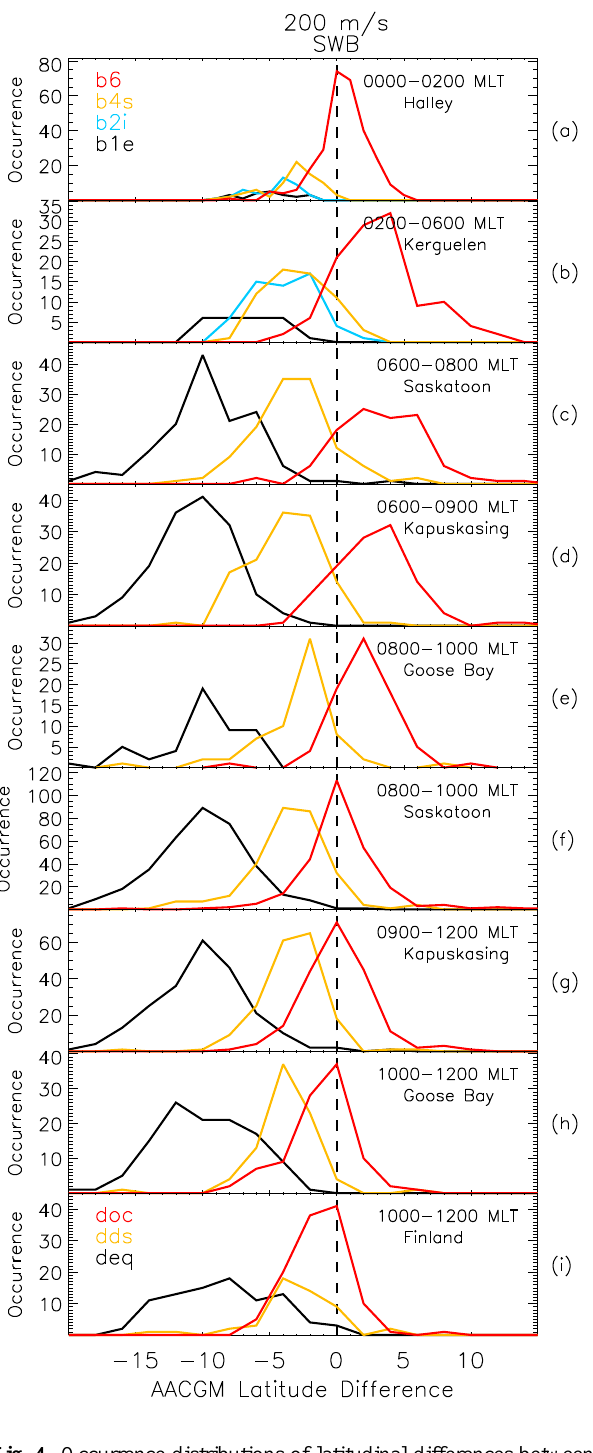
Fig. 4. Occurrence distributions of latitudinal differences between the DMSP PPBs and the 200m/s threshold SWB for a number of different SuperDARN radars in a range of MLT regions (as detailed in each panel). In panels a and b the four different distributions are for the nightside PPBs: b1e (black), b2i (blue), b4s (yellow), and b6 (red). In panels c – i the three different distributions are for the dayside PPBs: deq (black), dds (yellow), and doc (red).